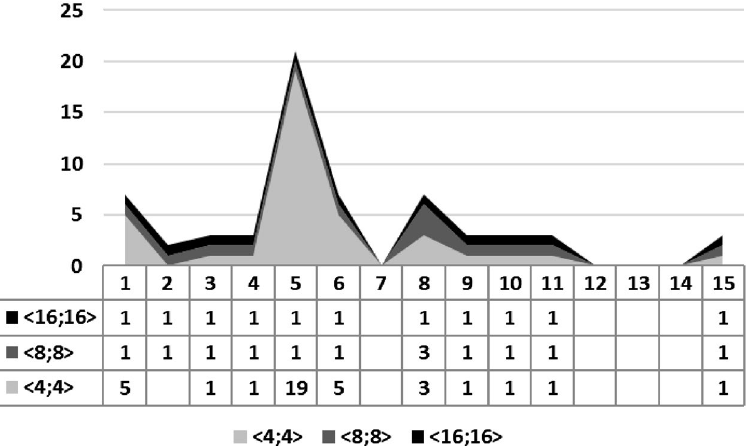
Figure 7. We illustrate the area chart for our overshoot experiments under different FWL formats ( (cid:31) 4, 4 (cid:30) , (cid:31) 8, 8 (cid:30) , and (cid:31) 16, 16 (cid:30) ) and the number of attempts to synthesis the digital controllers from 1 to 15. As we can observe, the FWL format directly influences the number of attempts to synthesize these digital controllers considering the overshoot specification.